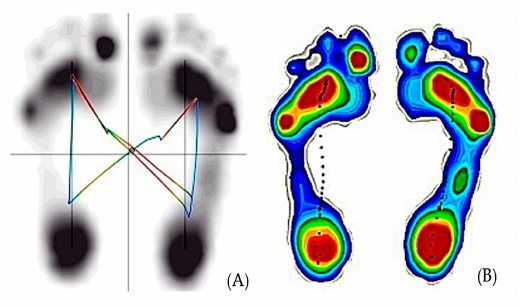
Figure 2. The data presented by the Zebris force plate. ( A ) Center of gravity (COG) parameters; ( B ) plantar surface area.